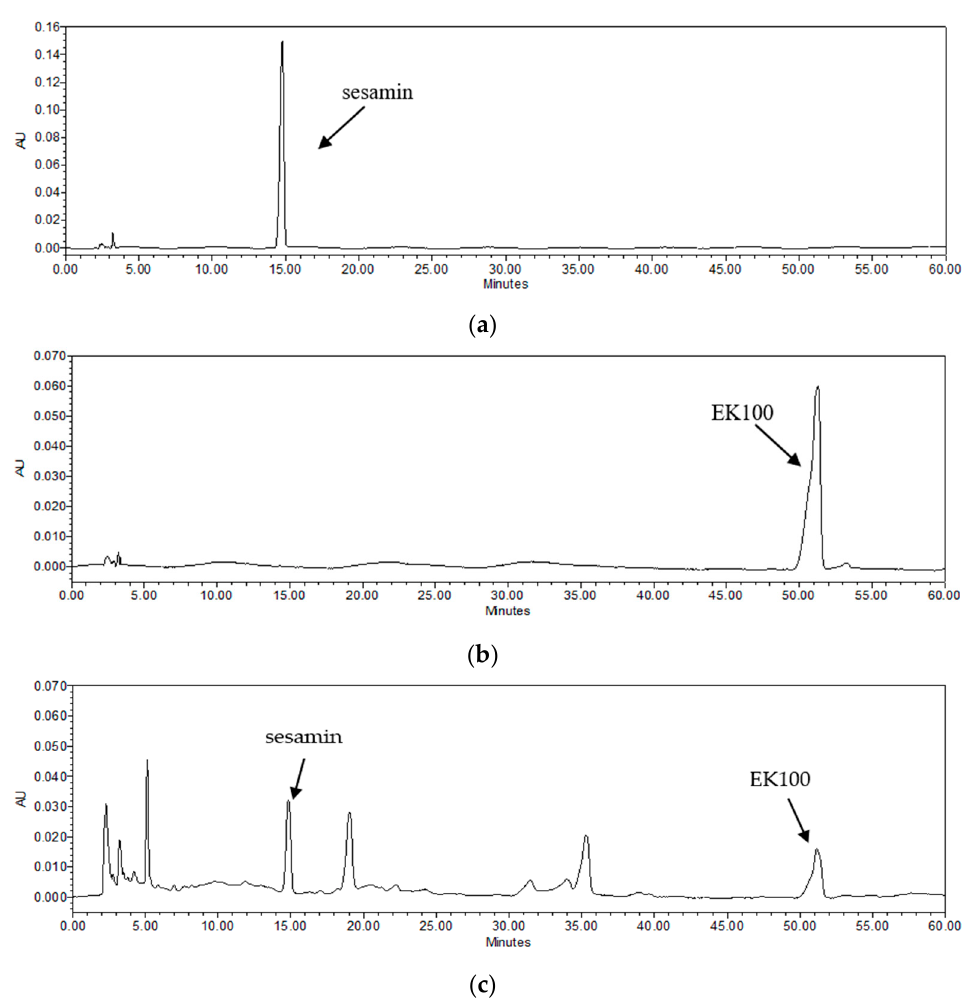
Figure 1. HPLC chromatograms of sesamin and EK100 in TC and standards. ( a ) sesamin standard, ( b ) EK100 standard, and ( c ) sesamin and EK100 in TC.